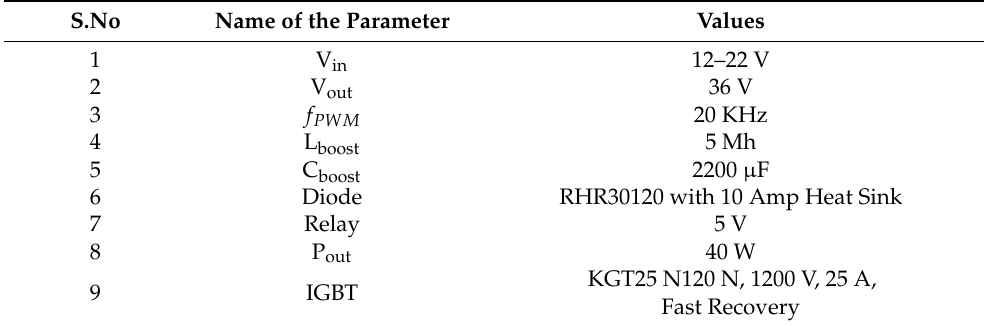
Table 2. Parameter of DC–DC boost converter.